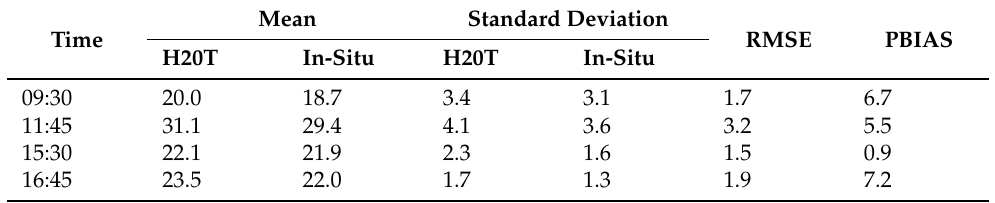
Table 4. Statistical comparison between Zenmuse H20T and in situ LST ( ◦ C) measurements.